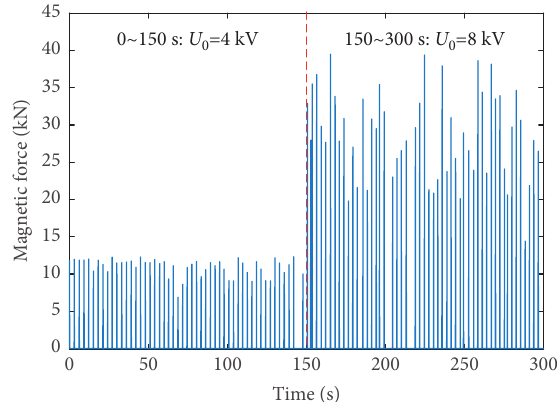
Figure 15: The magnetic force-time curve.